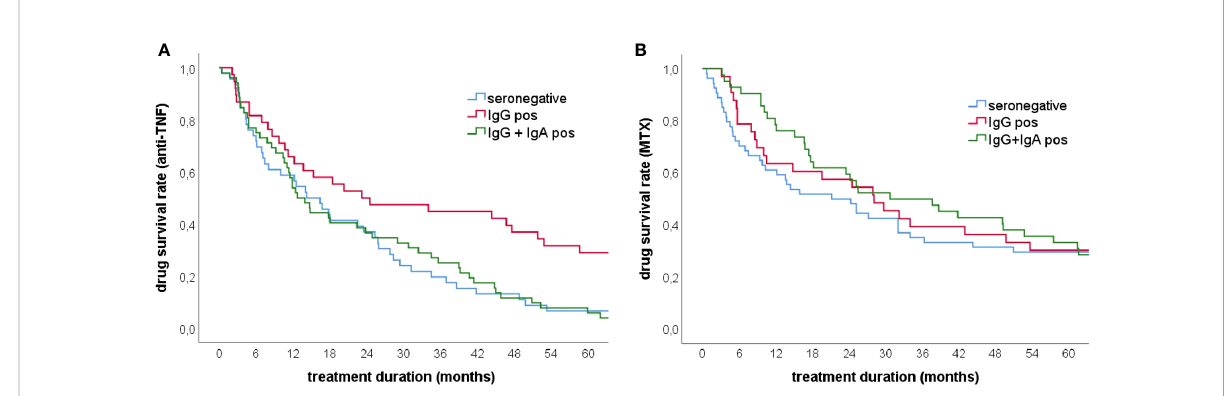
FIGURE 2 Drug survival rates for anti-TNF and methotrexate treatment in early RA patients. (A) Anti-TNF survival rates in patients showing anti-CCP2 IgG/ IgA antibodies (n=53), anti-CCP2 IgG antibodies (n=43) and seronegative patients (n=46) (B) Methotrexate survival rates in patients showing anti-CCP2 IgG/IgA antibodies (n=47), anti-CCP2 IgG antibodies (n=43) and seronegative patients (n=54). The presence of IgA antibodies was signi fi cantly associated with reduced anti-TNF retention rates while for MTX retention no signi fi cant difference was found between the